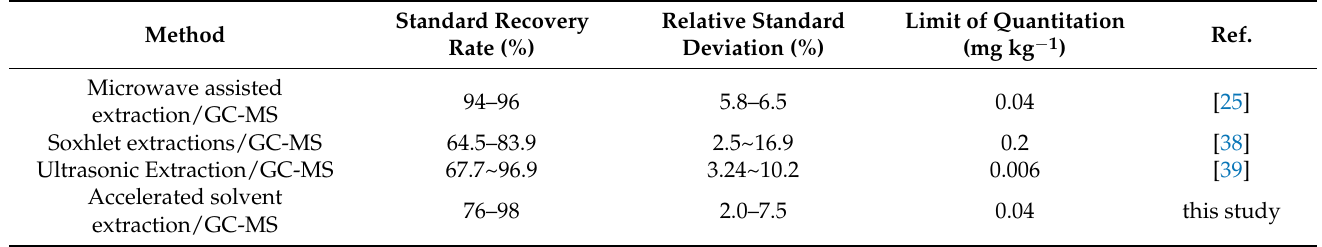
Table 5. Comparison of standard addition recovery, relative standard deviation and limit of quantita- tion of aniline by different